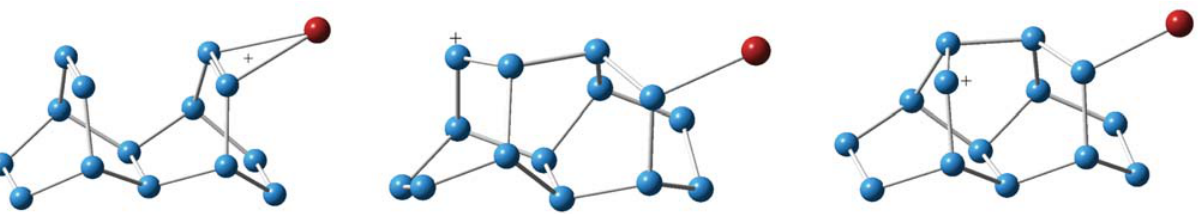
Table 3. The calculated relative energies of